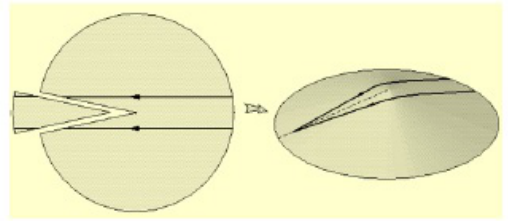
Figure 2. Initially parallel lines will cross if they straddle the